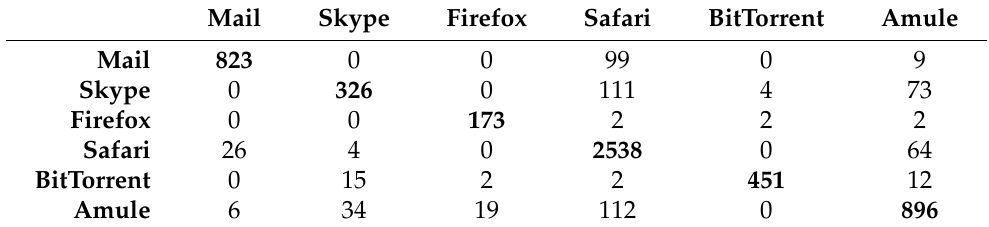
Table 17. Proposed method: confusion matrix (UniBS, statistical).